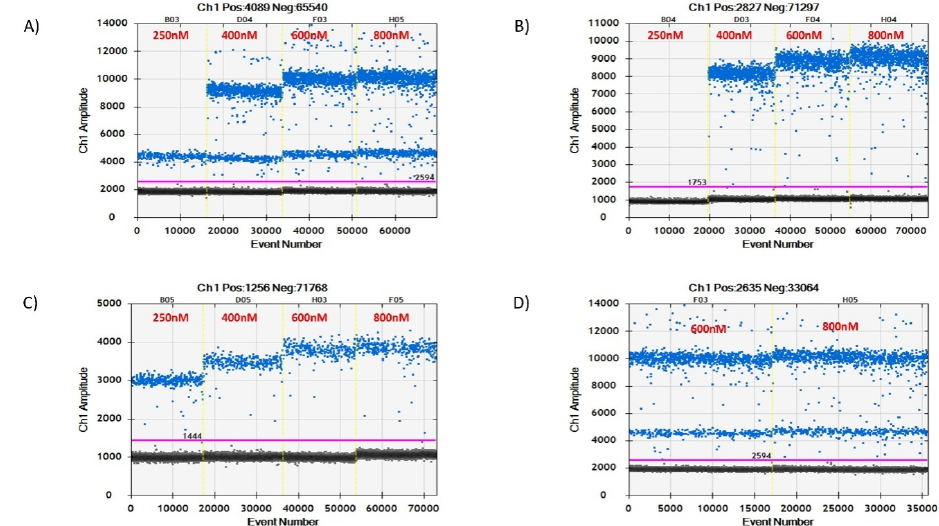
Figure 3. Primer concentration test of both simplex and duplex assays. ( B , C ) represent simplex assay results of both IS6110 and IS1081 genes, respectively, using various primer concentrations ranging from 250 nM to 800 nM. ( A ) is a duplex assay result containing both genes in a single reaction well. ( D ) is the optimal concentration result to be used in subsequent experiments.